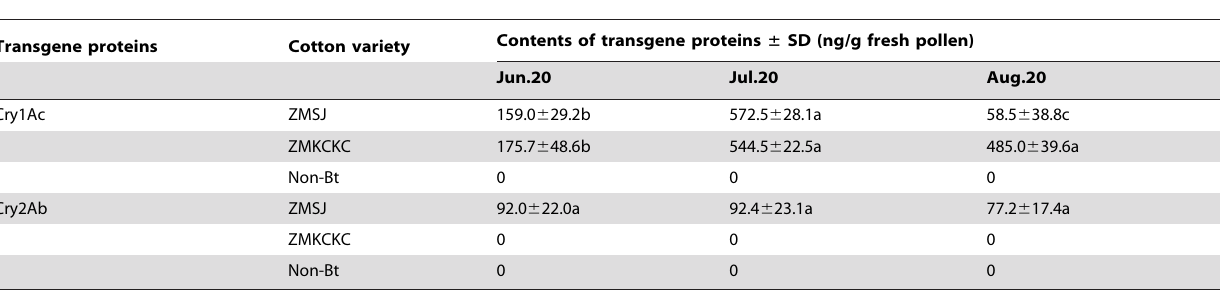
Table 1. Cry1Ac and Cry2Ab protein content in cotton pollen from the transgenic ZMSJ cotton, ZMKCKC cotton and the non-Bt cotton as assayed by ELISA method.